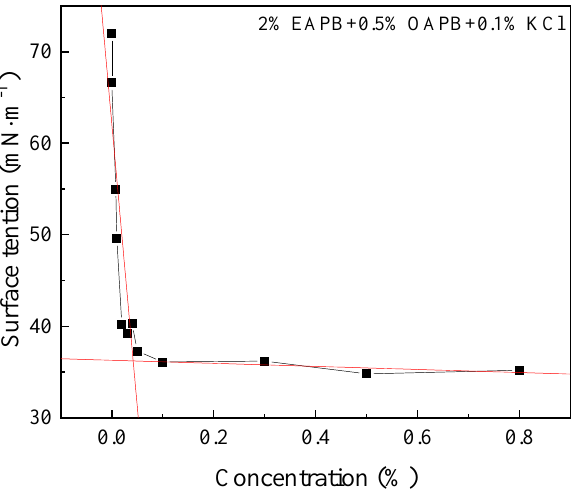
Figure 12. Surface tension of VES-based fracturing fluid at room temperature (27 °C).